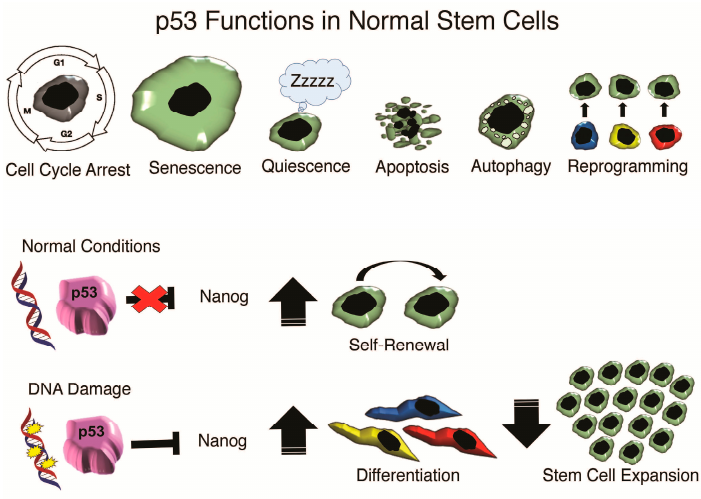
Figure 2. p53 functions in normal stem cells at normal conditions and DNA damage.